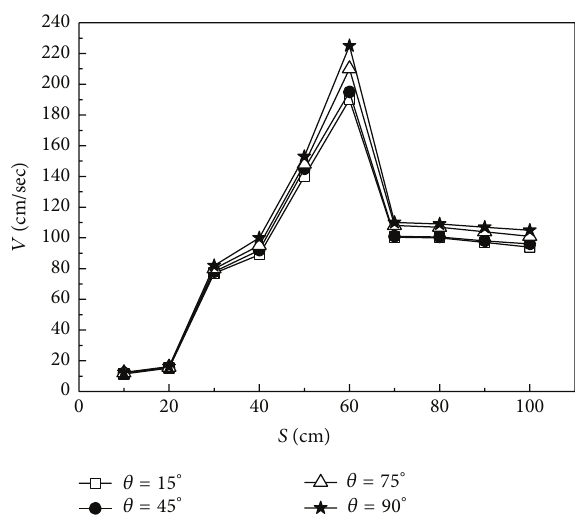
Figure 4: The first normal stress difference as a function of the shear rate for the studied solutions.